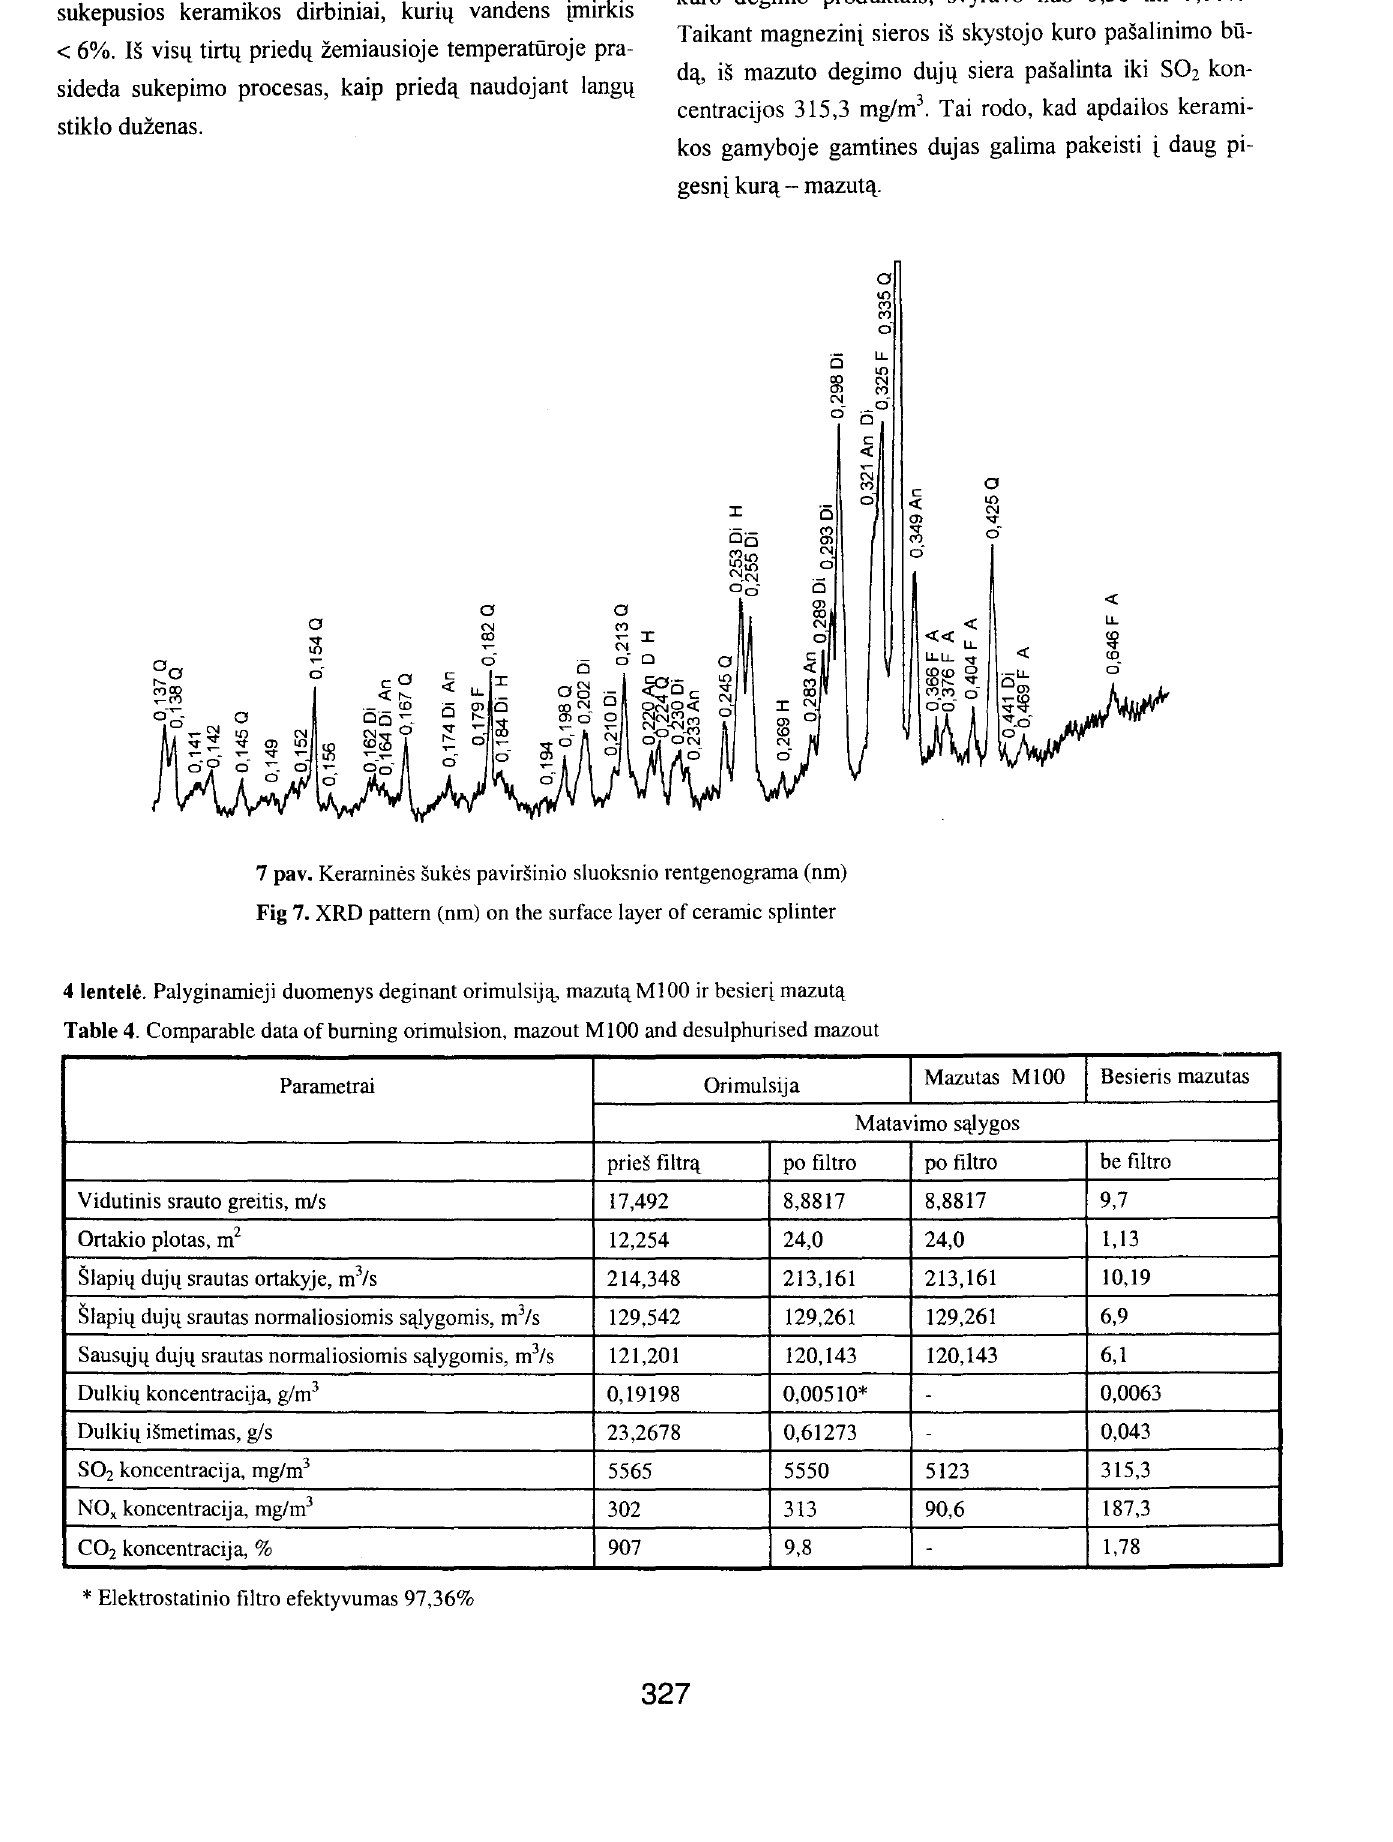
Fig 7. XRD pattern (nm) on the surface layer of ceramic splinter